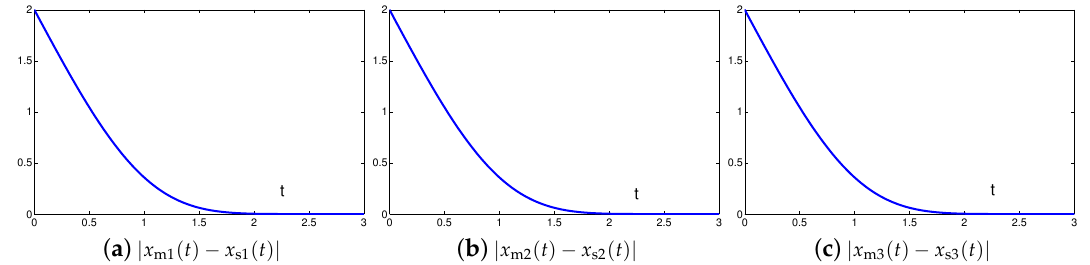
Figure 9. Absolute errors between two nonidentical chaotic systems (24) and (28) equipped with controller (6) via the proposed SEZN